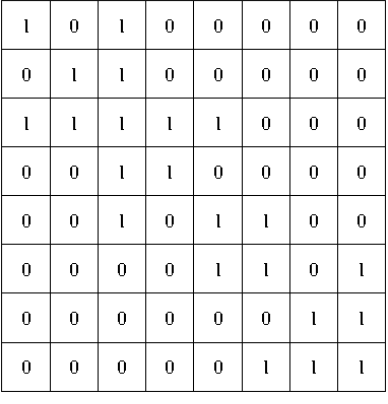
Figure 3. Adjacency matrix